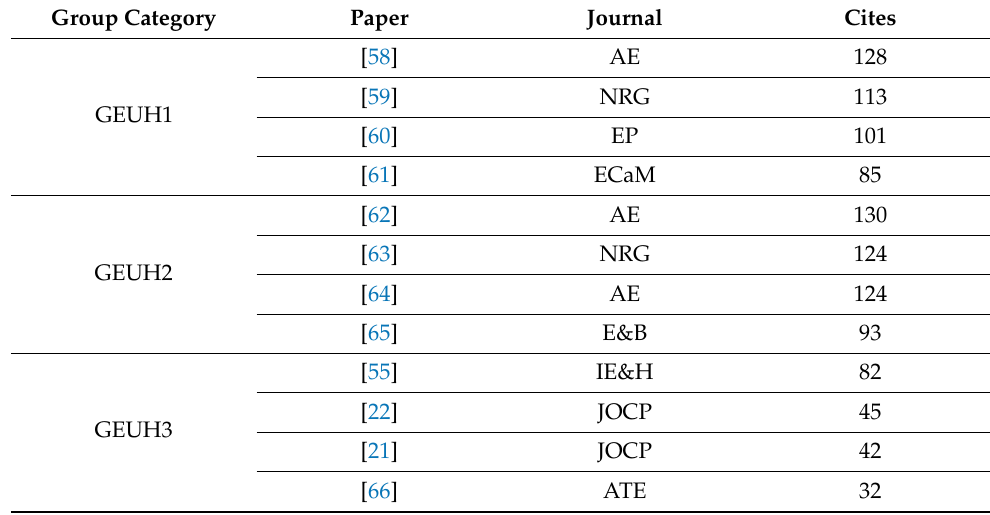
Table 2. The most frequently cited papers in each Energy-Upgrade Hospital Group category. Group